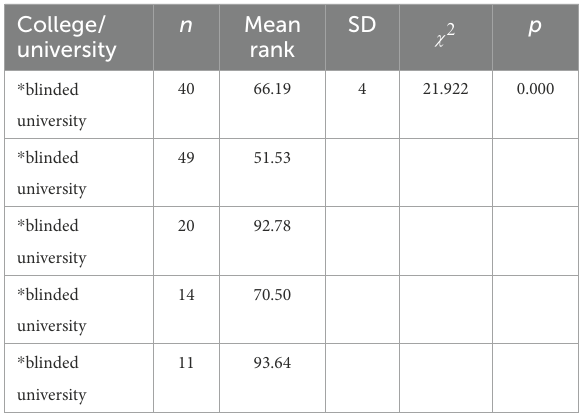
TABLE 7 H-Test results of similarity indexes of postgraduate theses in Turkey grouped by institution.